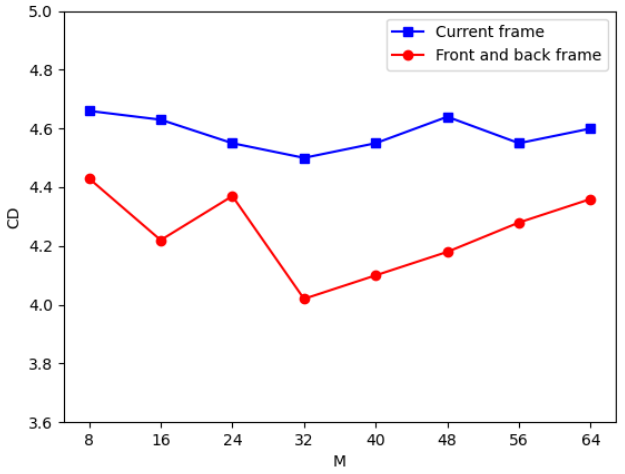
Figure 4. Parameter selection